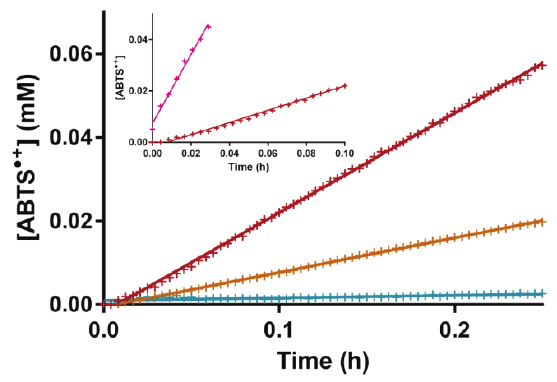
O catalysed by 2 2